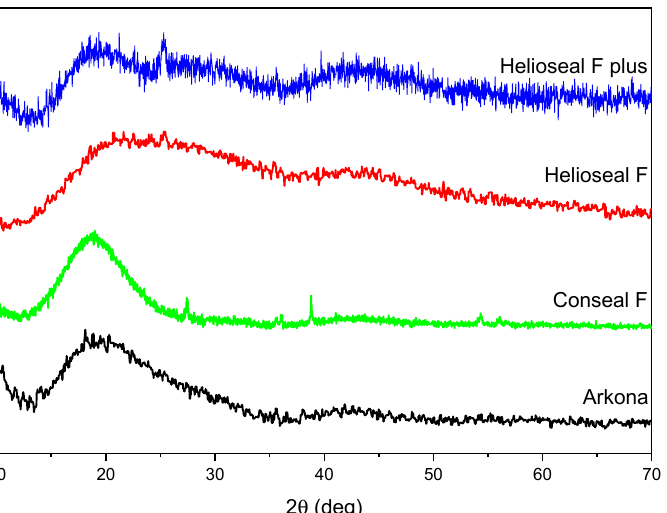
Figure 1. XRD diagrams of different fissure sealants. The study was performed for one randomly selected sample of each material: Arkona; Conseal F; Helioseal F; Helioseal F Plus.